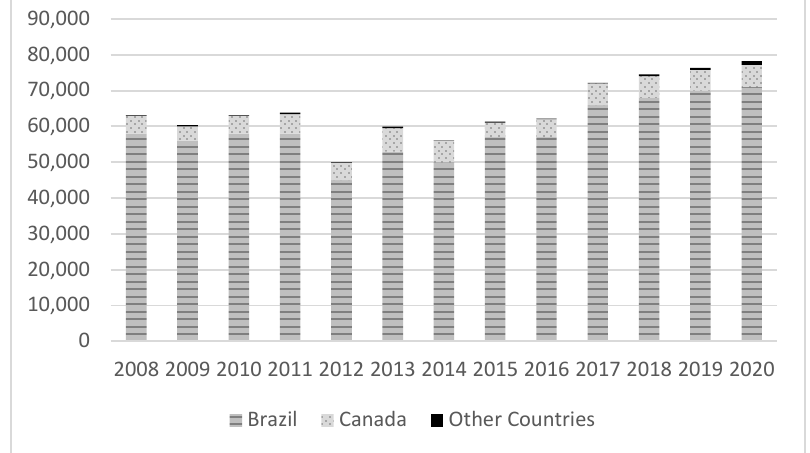
Figure 1. Historical production of niobium in metric tons, adapted from [23].